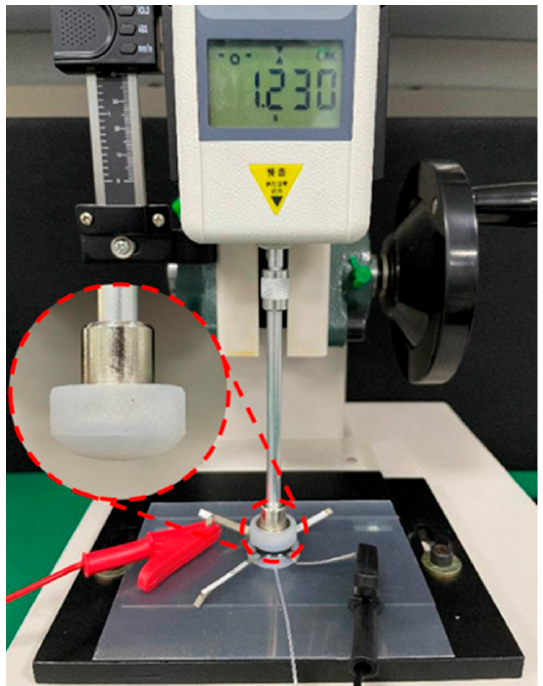
Figure 5. The output force measurement of the SEHPA. The inset is an enlarged view of the silicone wrapped test head.